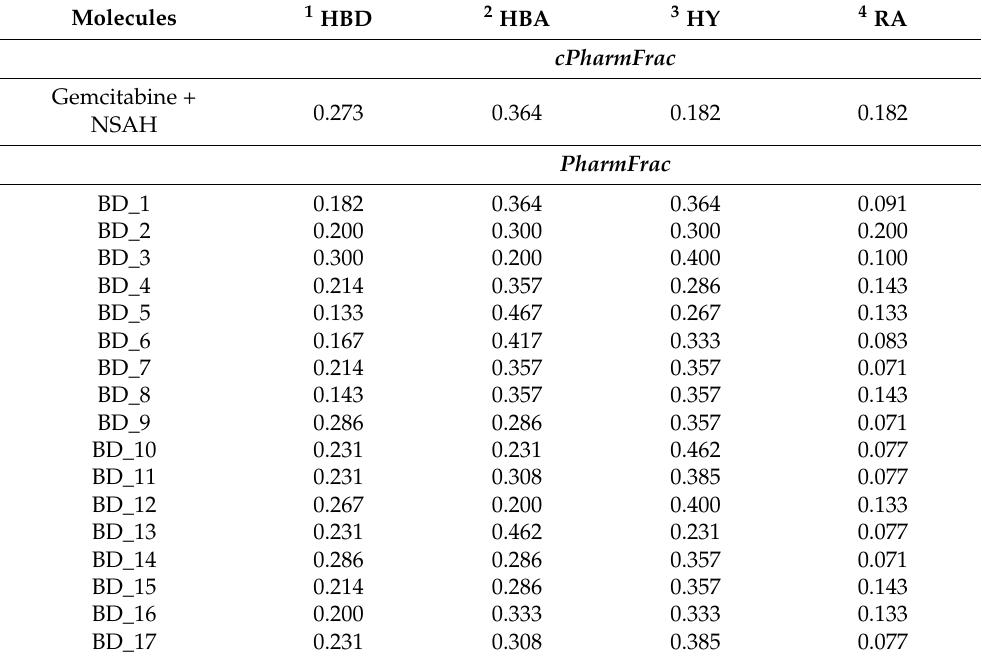
Table 3. cPharmFrac and PharmFrac of hRRM1 inhibitors obtained from Python RDKit. Molecules 1 HBD 2